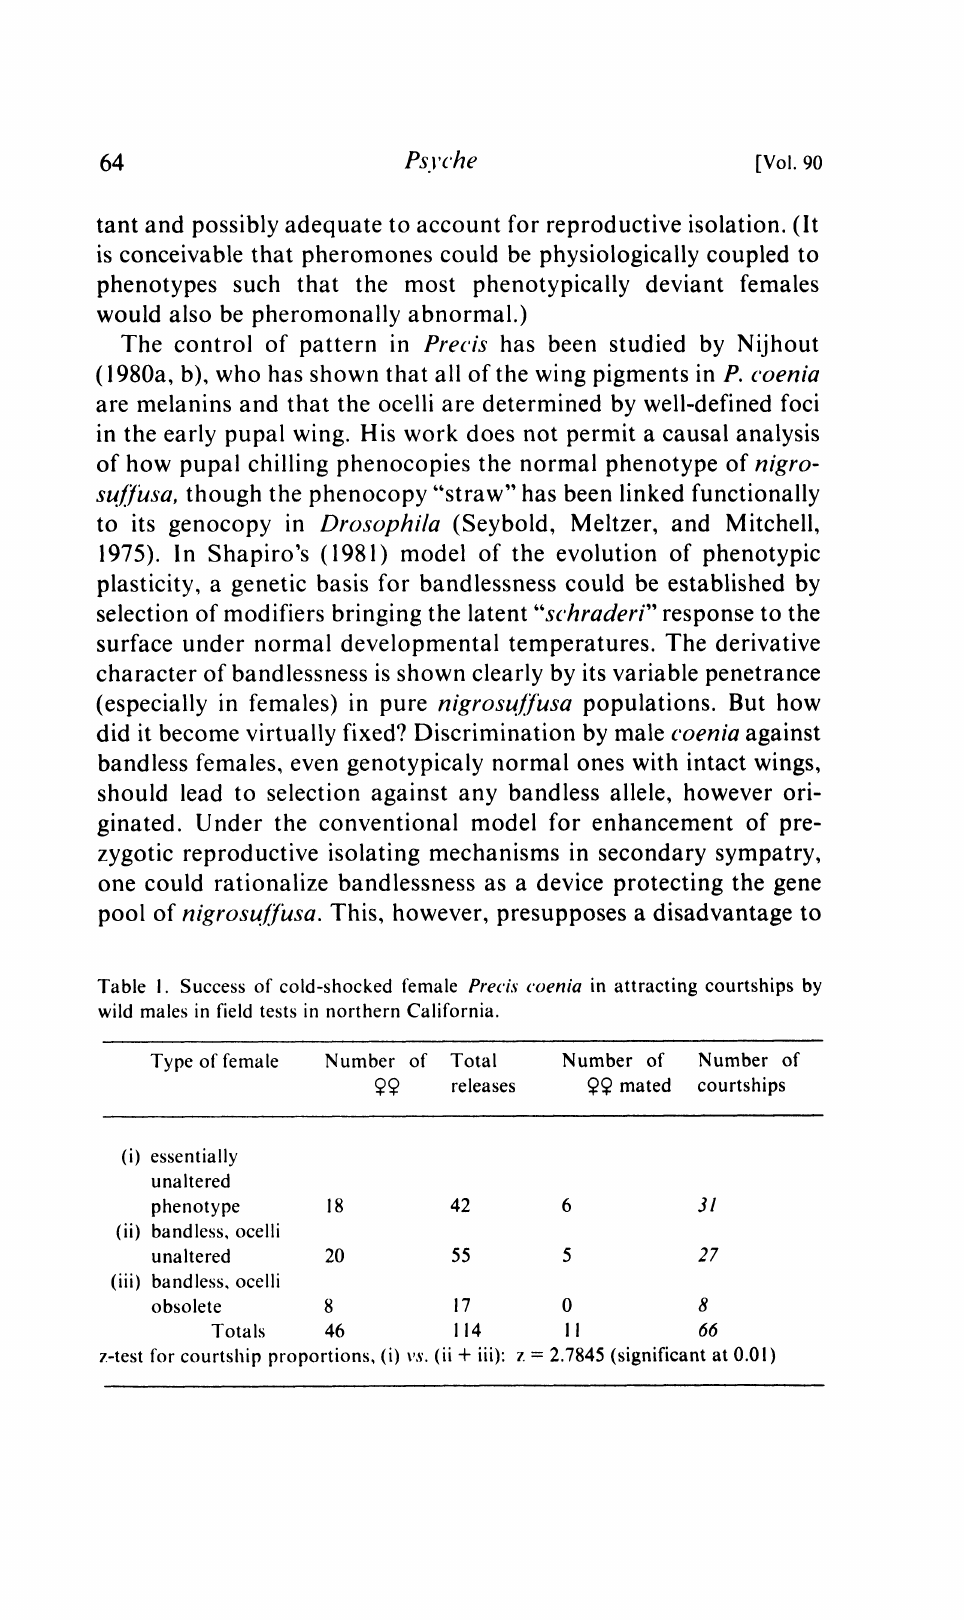
Table I. Success of cold-shocked female Precis coenia in attracting courtships by wild males in field tests in northern